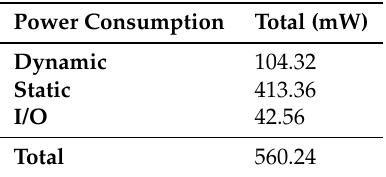
Table 9. Power consumption for the ANNM